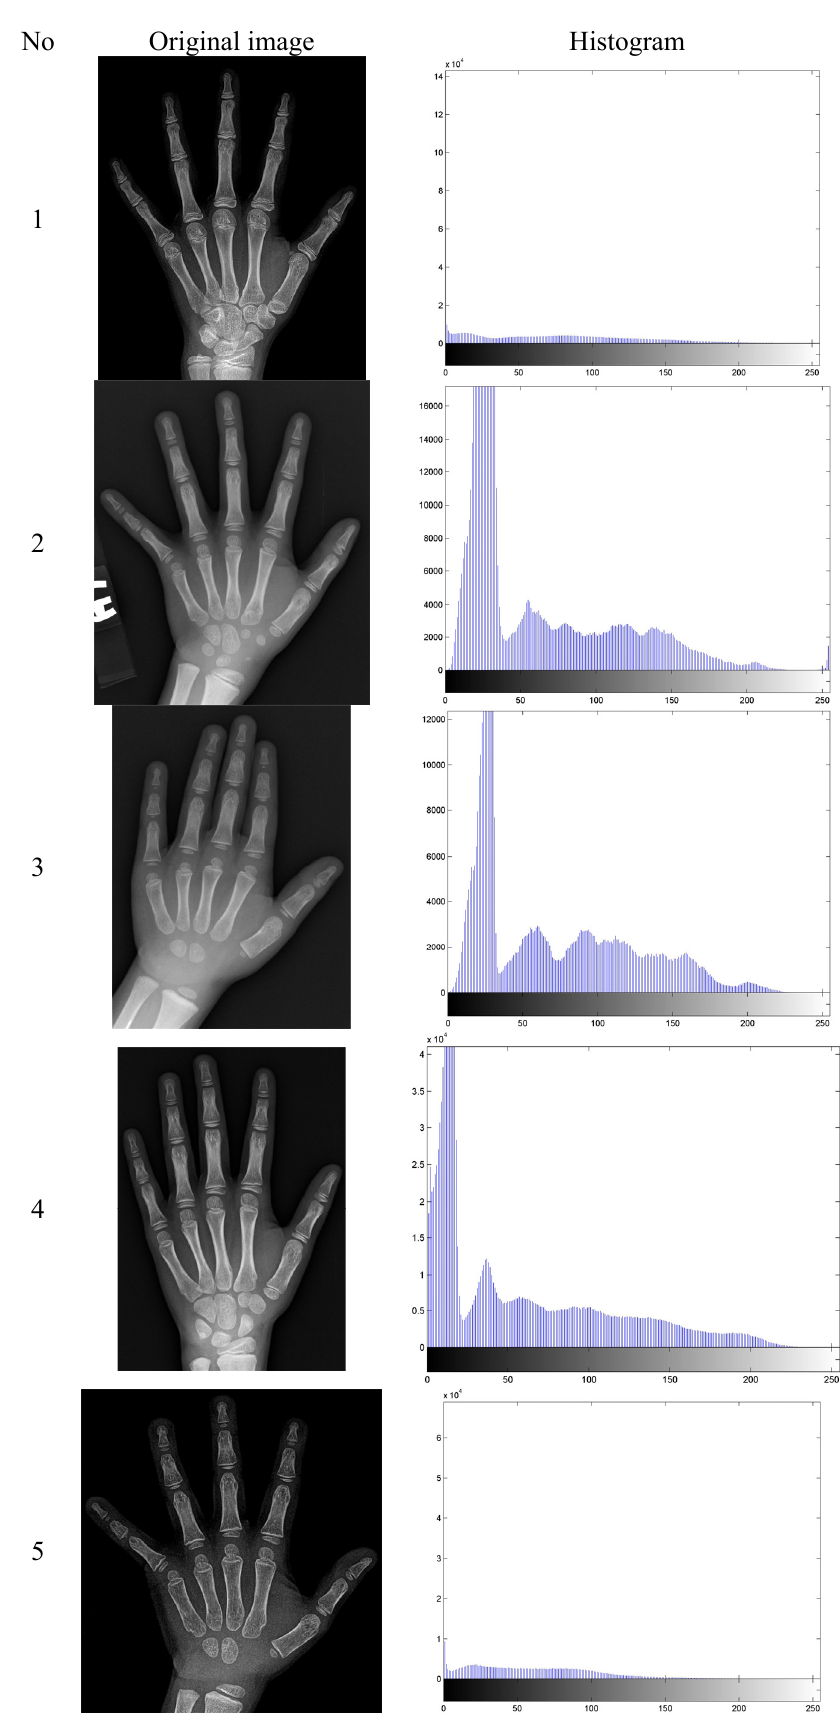
Figure 1. The original grayscale images and their